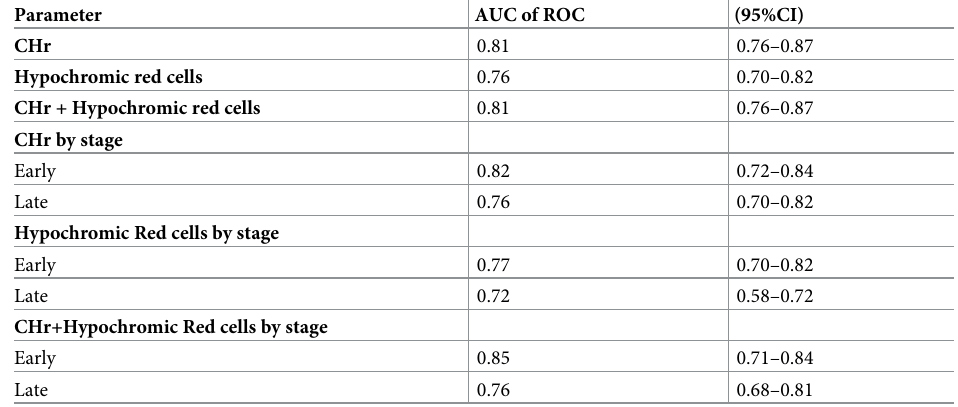
Table 6. Performance of reticulocyte haemoglobin content and percentage hypochromic red cells in the diagnosis of iron deficiency anaemia in chronic kidney disease participants.